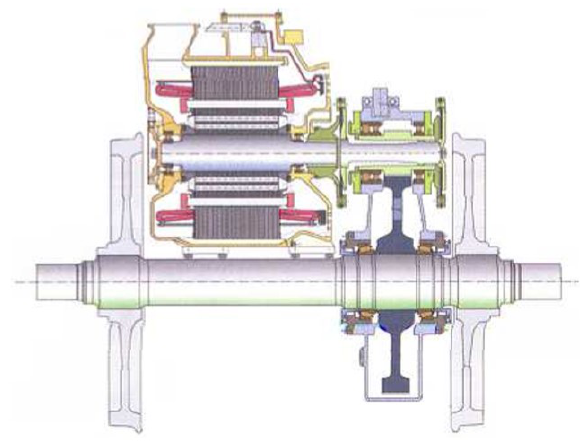
Figure 1. A partly-suspended drive of a locomotive [1].